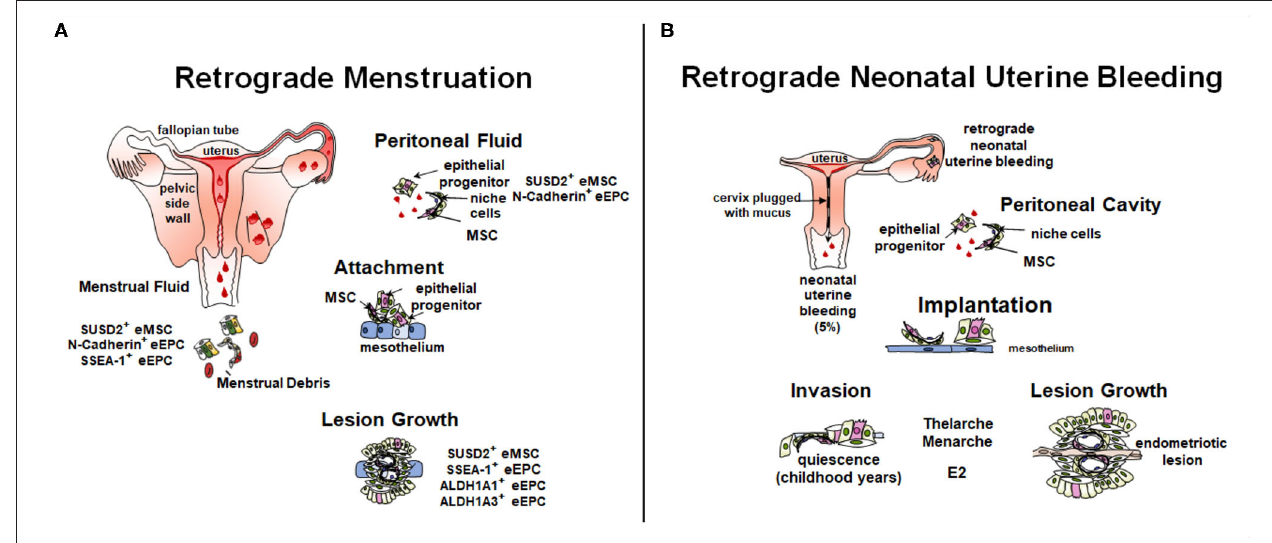
FIGURE 3 | Role of stem/progenitor cells in the pathology of endometriosis. (A) In the adult, retrograde menstruation, results in stem/progenitor cells entering the peritoneal cavity. In some circumstances, stem/progenitor cells are able to survive and contribute to lesions establishment and progression. (B) Retrograde neonatal bleeding is observed in 5% of female born babies. Epithelial progenitors and eMSC enter the peritoneal cavity and remain quiescent until puberty, where increasing concentrations of estradiol (E2) stimulate lesion growth. Created with BioRender.com, adapted from